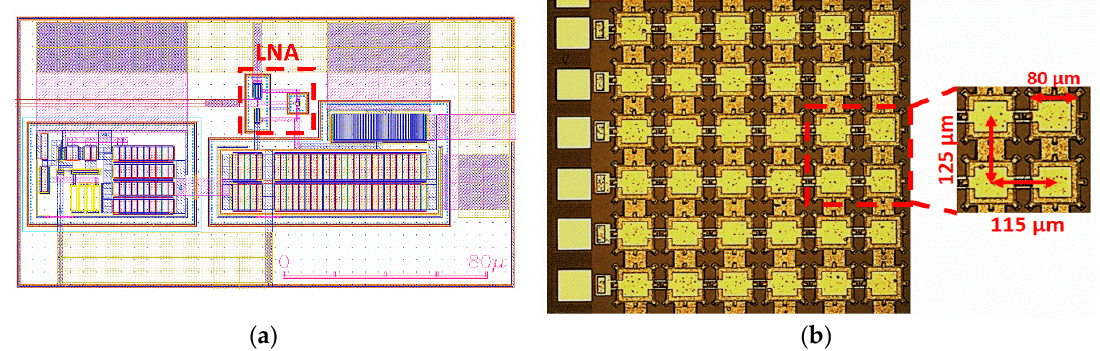
Figure 7. ( a ) Layout of the LNA (VA topology) with an output buffer. The LNA dimensions are 23 μ m of width and 25 μ m of length. ( b ) Optical image of a 6 × 6 (square) 80- μ m/side PMUT array.